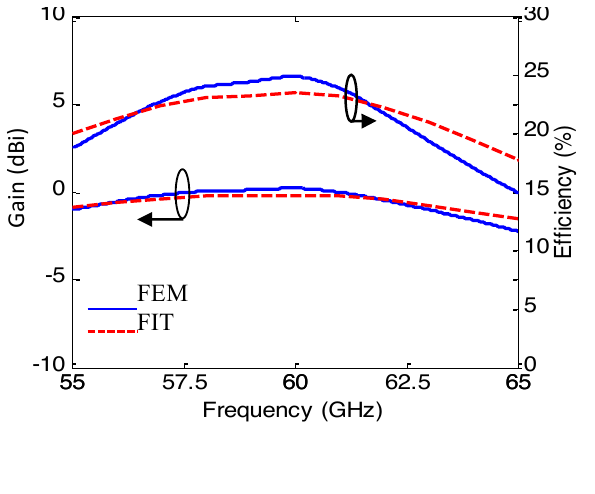
Fig. 3 a. The variations of the gain and radiation efficiency versus frequency of CP microstrip patch on-chip antenna. b. The variation of the radiation efficiency versus the silicon oxide thickness. c. The variation of the axial ratio versus frequency for CP microstrip patch on-chip